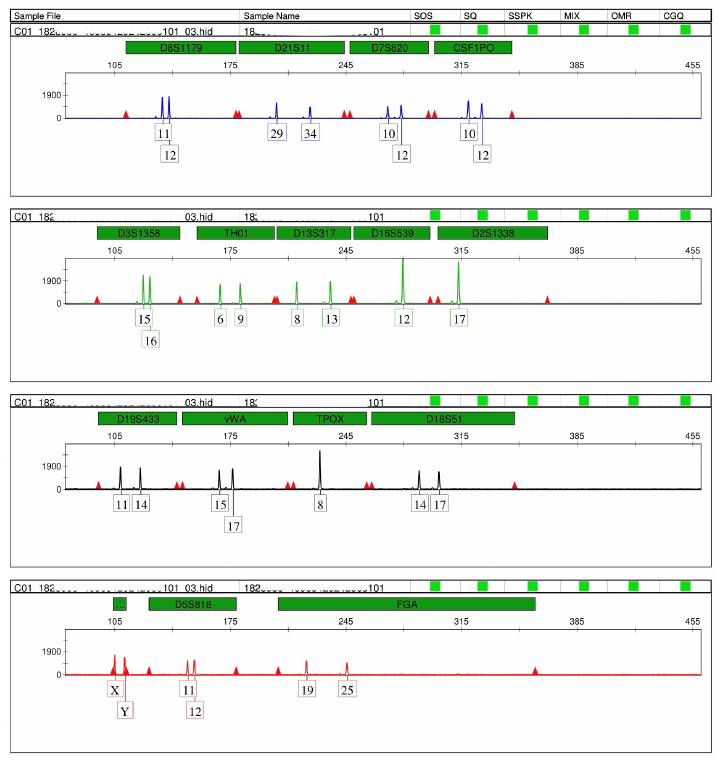
Figure 3. Male DNA